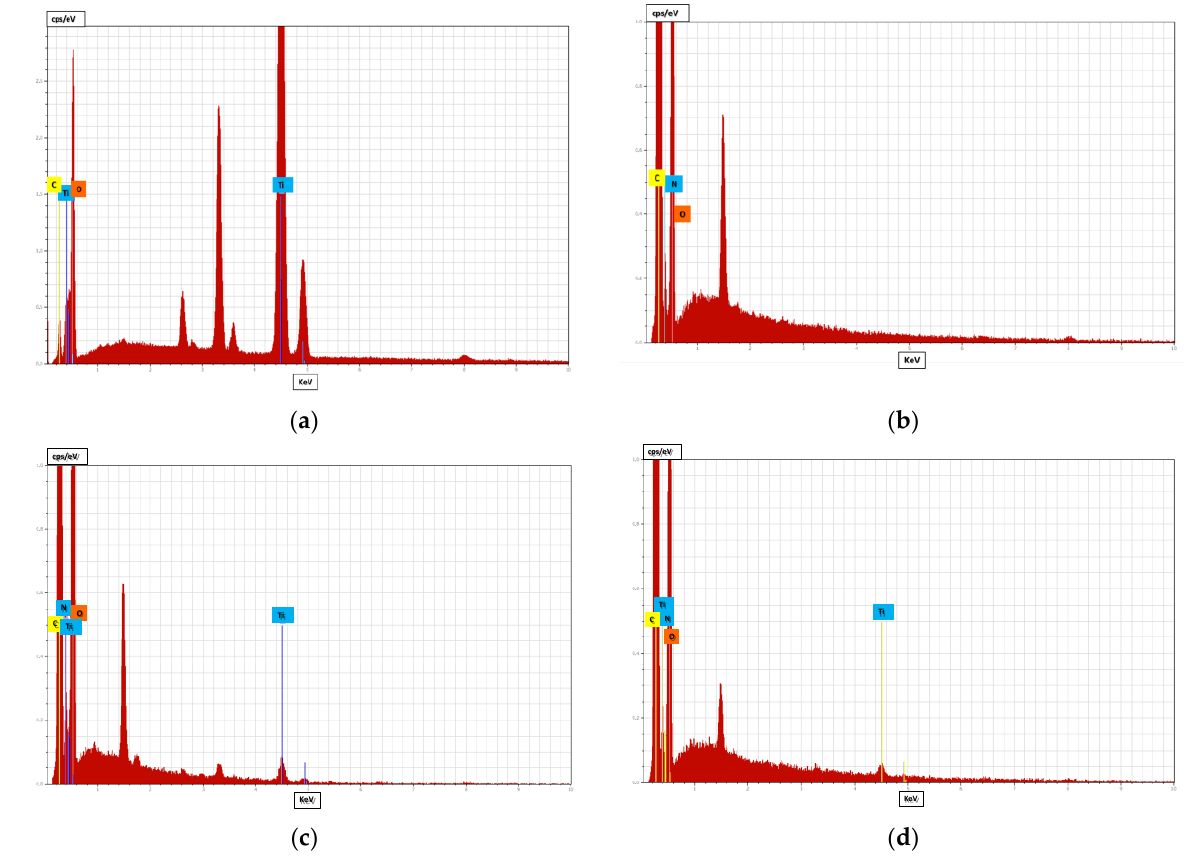
Figure 3. The EDS spectra of TiO 2 NWs ( a ), TPU ( b ) and the TPU – TiO 2 NW composites having the TiO 2 NW concentration equal to 2 wt.% ( c ) and 17 wt.% ( d ). The unassigned maxima belong to the sample fixation substrate.